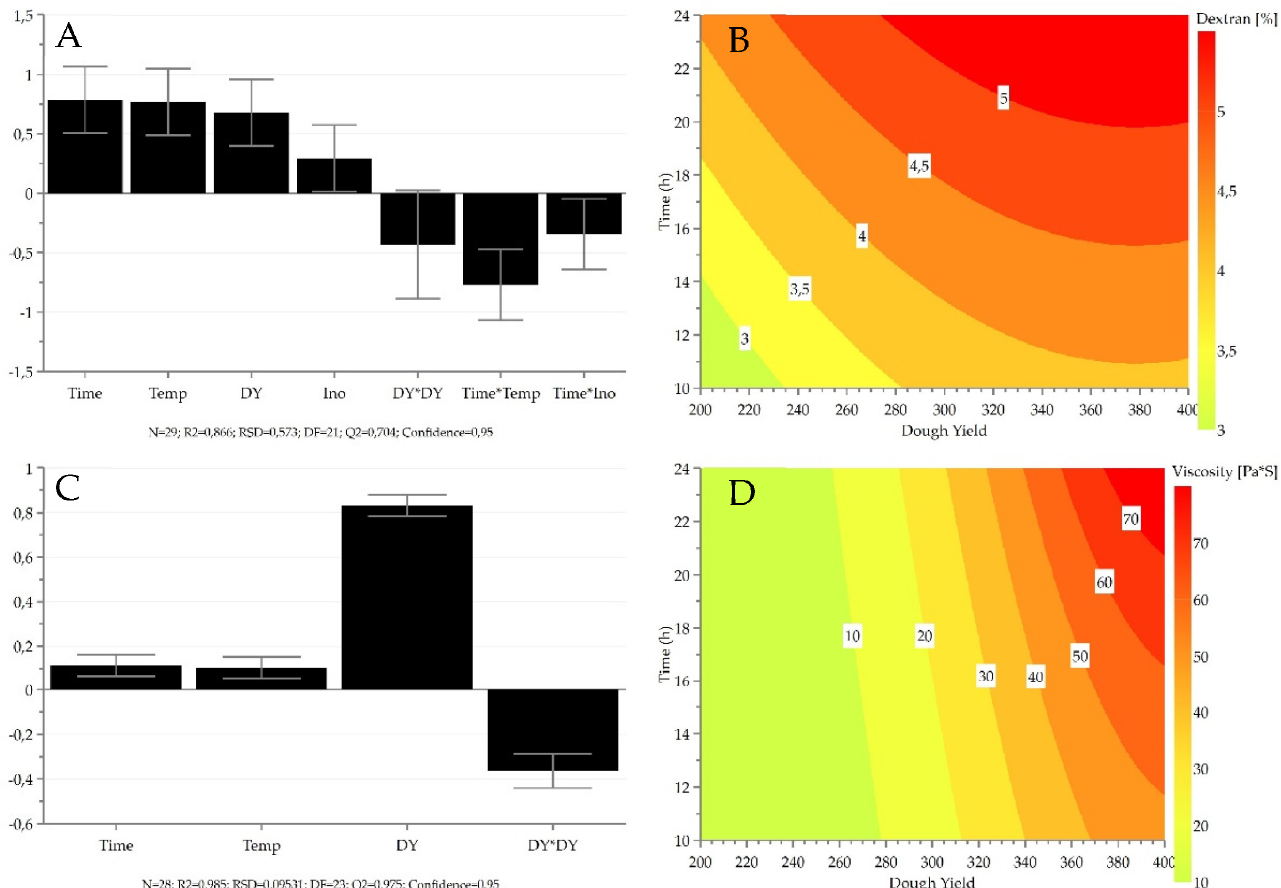
Figure 3. Coefficient plots showing the regression coefficients for the measured responses of dextran ( A ) and viscosity ( C ). Bars indicate the variation in response when a factor changes from 0 to high. The higher the bar, the stronger the effect of the variable on the indicated response. Positive and negative bars indicate a positive and negative effect, respectively. Error bars indicate the 95% confidence interval. ( B , D ) show the response surface plots as a function of dough yield and time for dextran and viscosity, respectively. Temperature and inoculum ratio were left constant at 25 ◦ C and 6 log CFU/g, respectively. Temp—temperature; DY—dough yield; Ino—inoculum ratio; N—number of observations; R2—explained variation; RSD—residual standard deviation; DF—degrees of freedom; Q2—predicted variation.